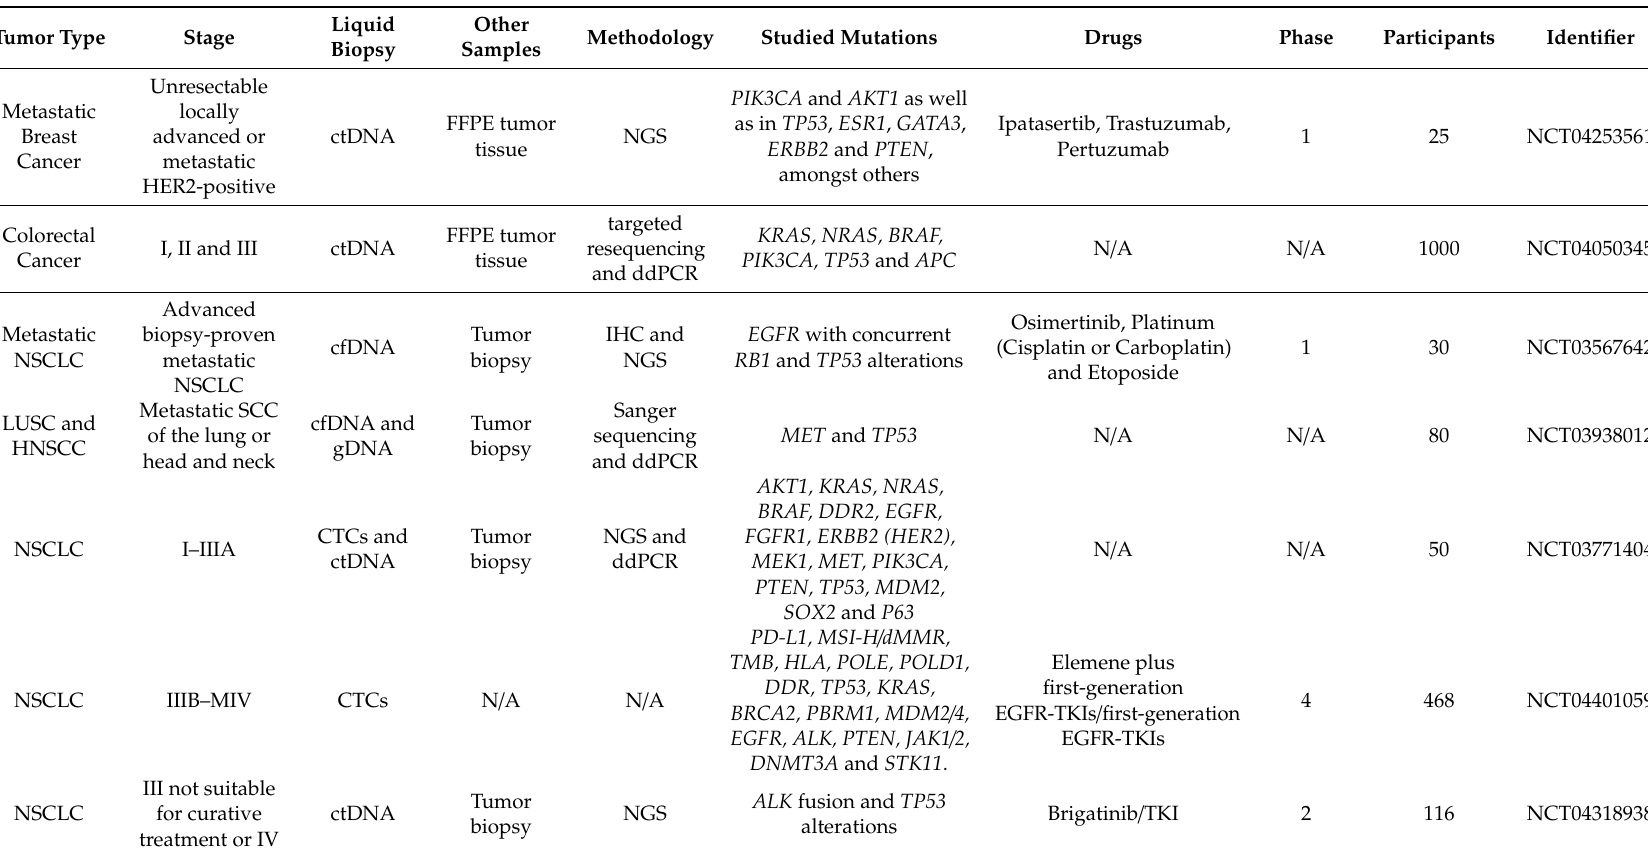
Table 2. Clinical trials analyzing TP53 mutations, among others, in liquid biopsies (either circulating tumor cells or cell-free DNA) as well as other biological samples. Tumor